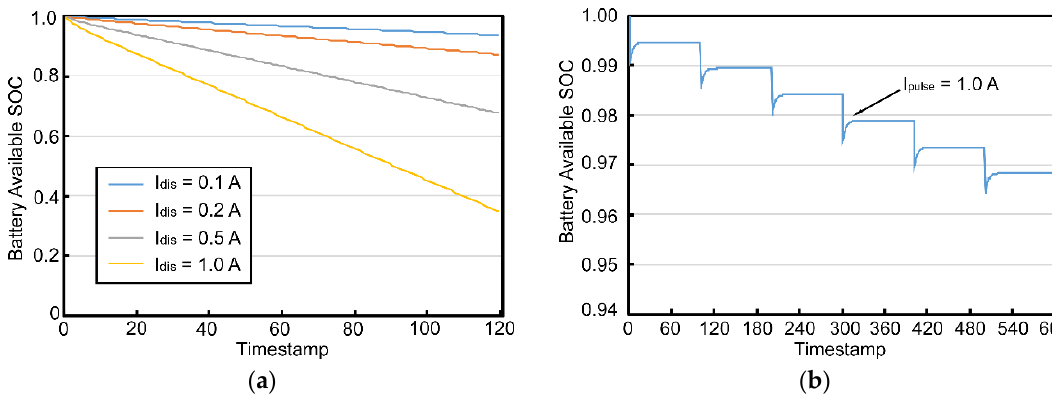
Figure 3. ( a ) Rate capacity effect. ( b ) Recovery effect. The simulation was performed with an 18650 lithium-ion battery model described in Table I.